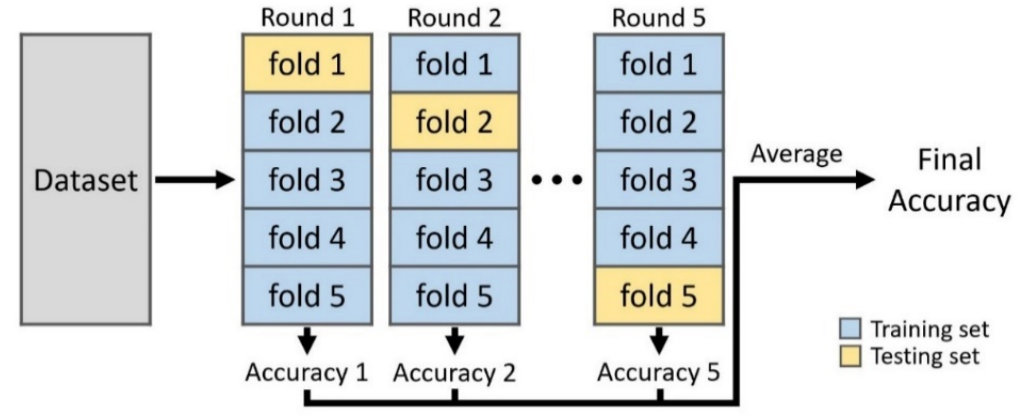
Figure 7. Flowchart of five-fold cross validation.